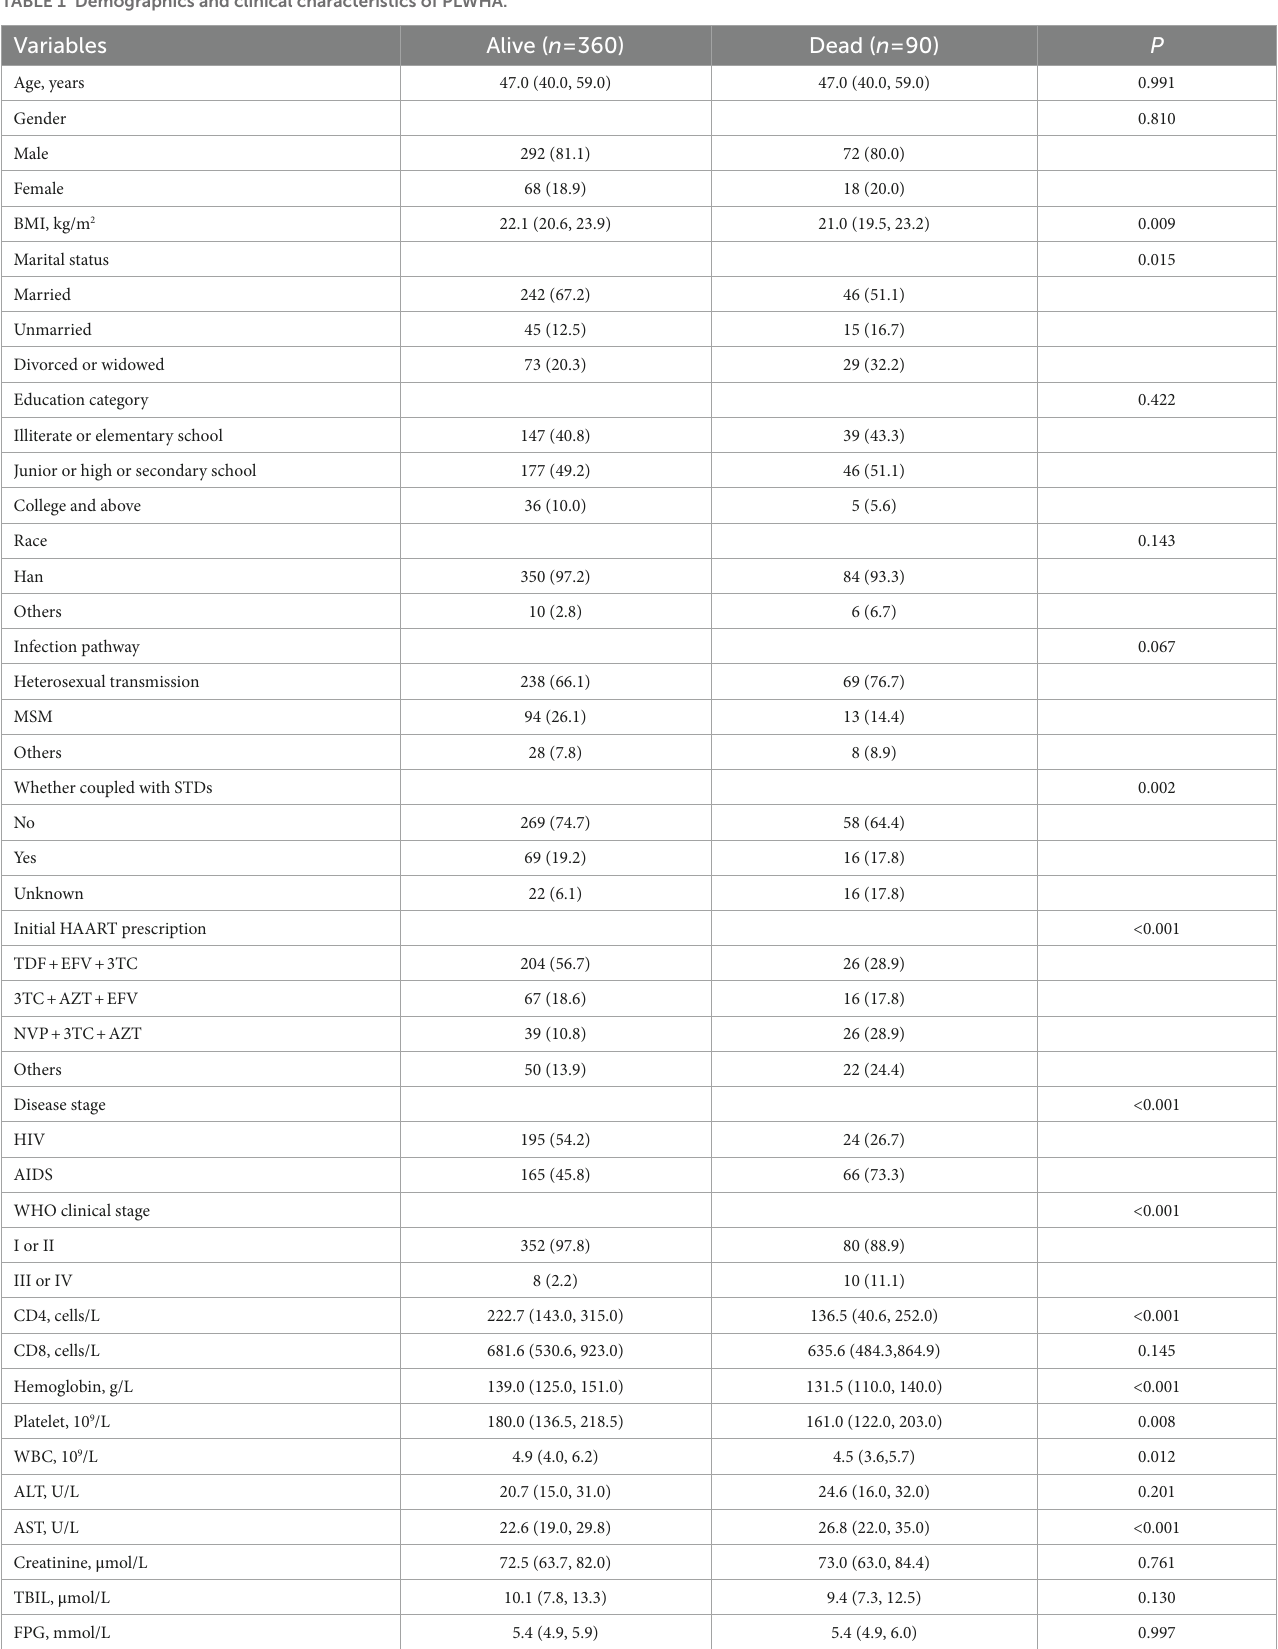
TABLE 1 Demographics and clinical characteristics of